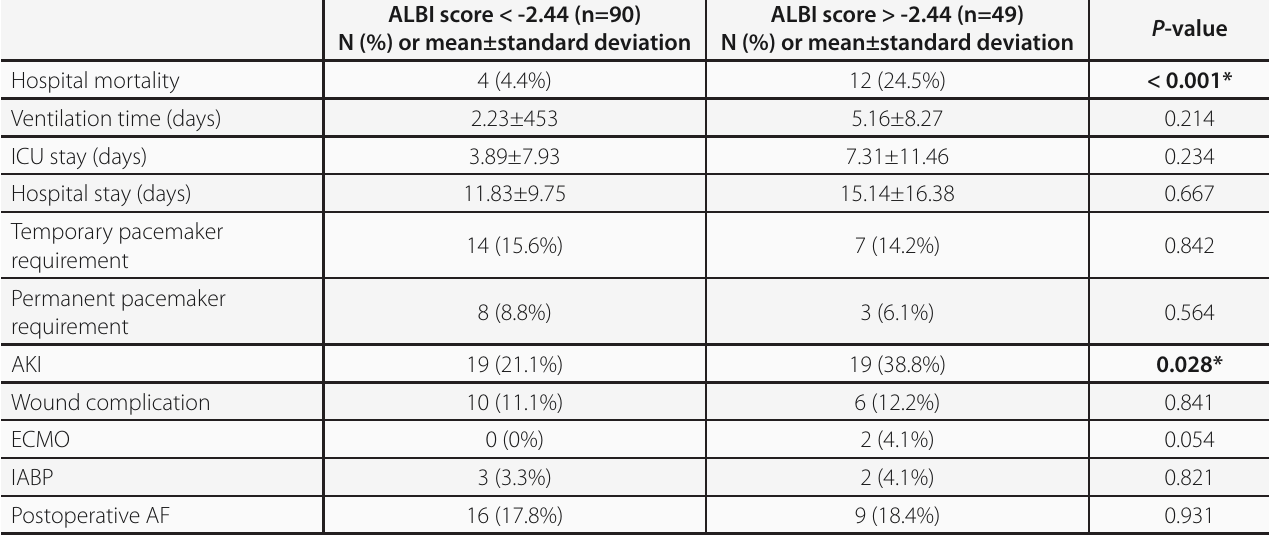
Table 5. Comparison of postoperative complications according to the ALBI score greater and lesser than -2.44. ALBI score < -2.44